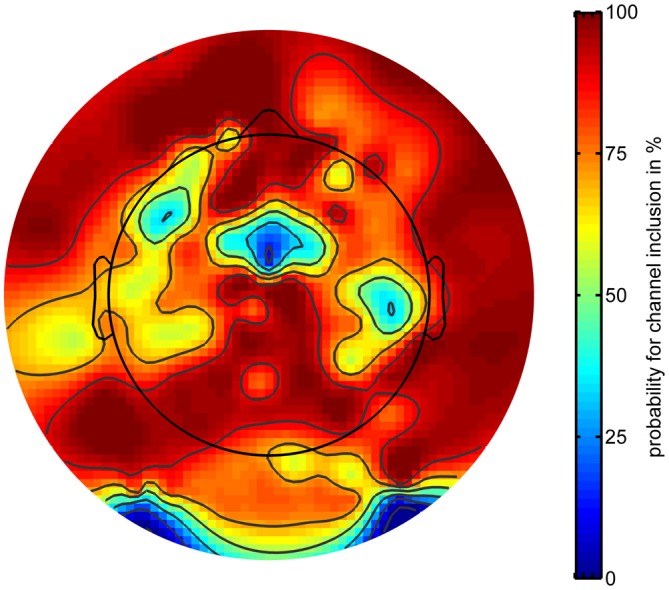
Probability of electrodes to be included in subsequent analyses as a function of electrode location. Warm (red) colors indicate higher probabilities.